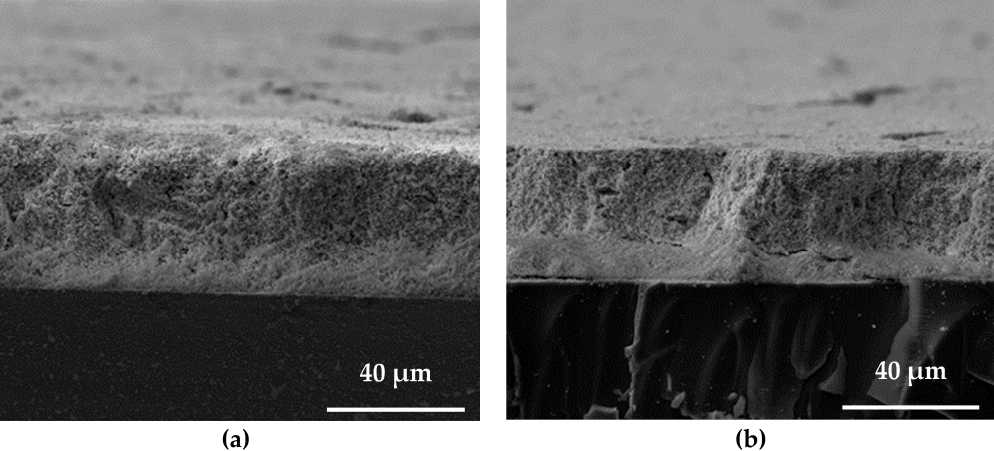
(d) Figure 8. SEM images of PZT laser sintered using ( a ) 40%, ( b ) 60%, ( c ) 80% and ( d ) 100% power. To check the sintering results along the transverse cross-section, SEM images were taken along the thicknesses of the samples. The images are shown in Figure 9. The lower